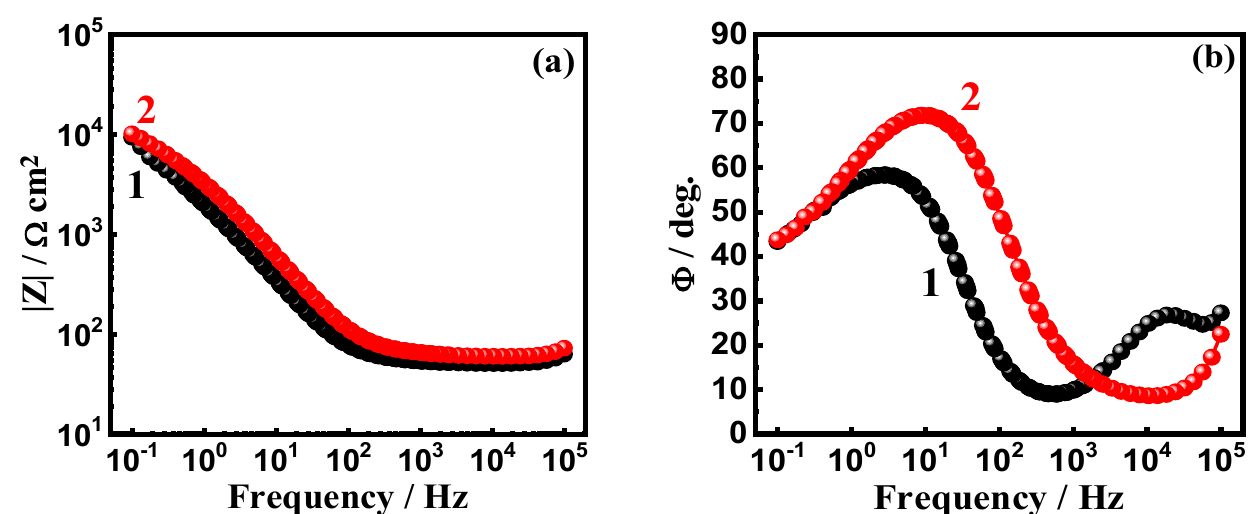
Crystals 2021 , 11 , x FOR PEER REVIEW 8 of 12